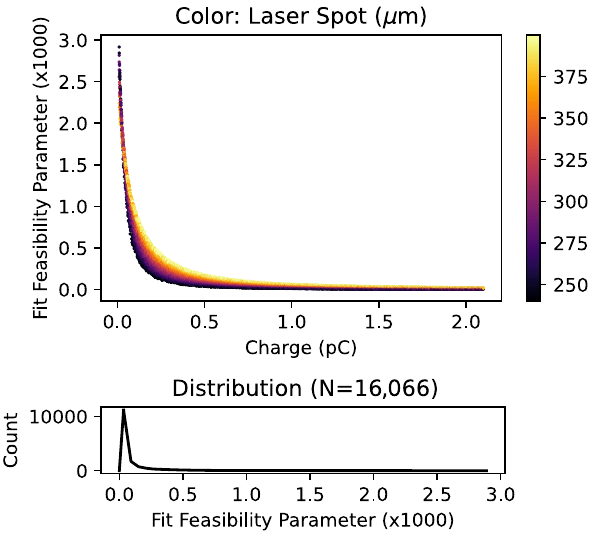
FIG. 5. Top: scatter plot of the fit feasibility parameter according to Eq. (15) vs the bunch charge for all training datasets. γ ¼ 6 . 8 for this population. The color indicates the laser spot size on the cathode for each dataset. Bottom: distri- bution of the fit feasibility parameter. Note that the plot shows the values multiplied by 1000 for readability